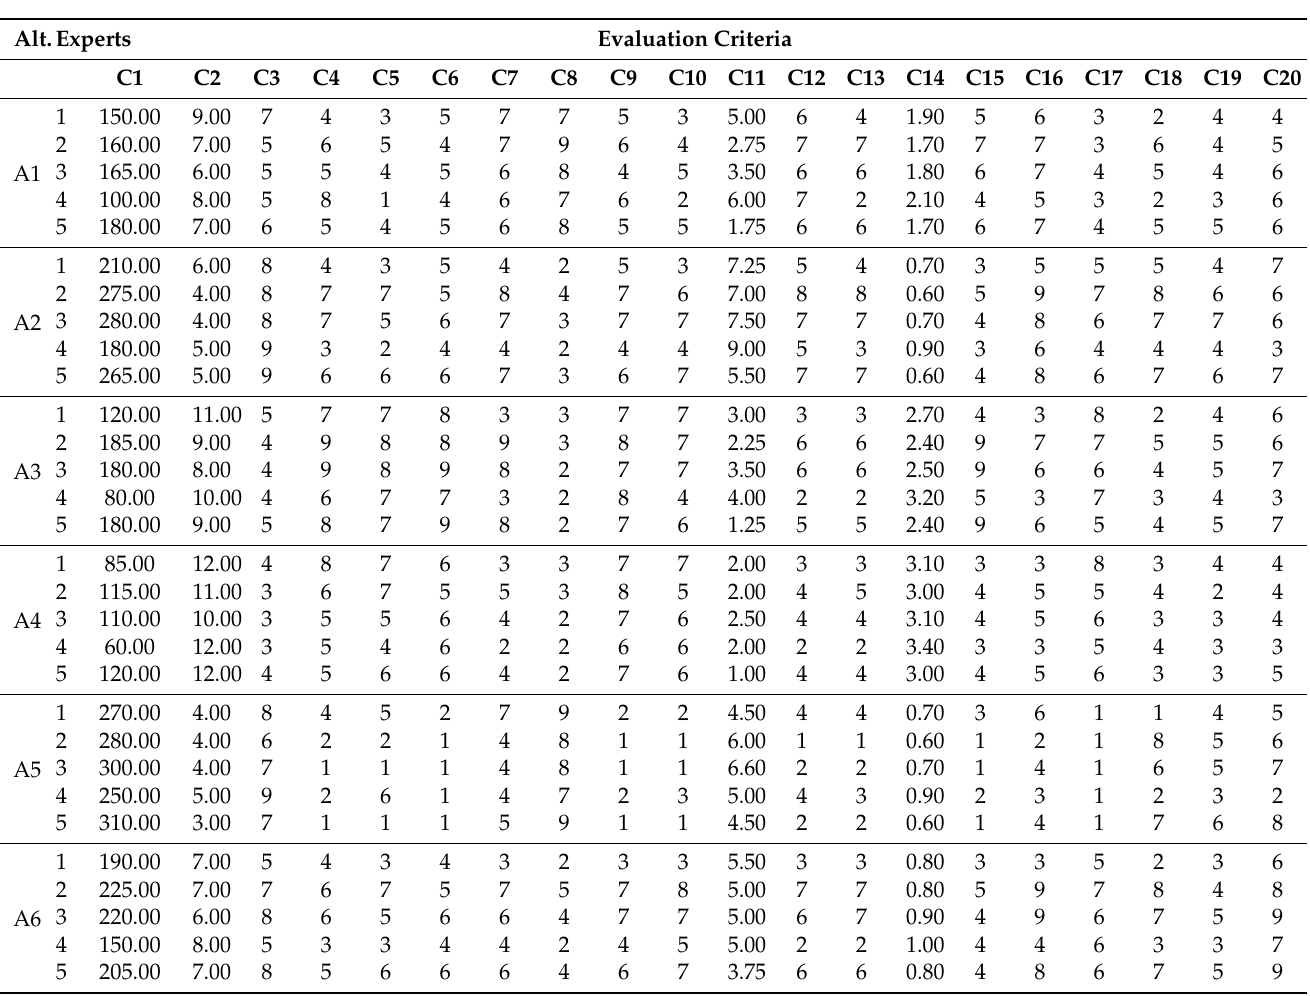
Table 5. Evaluation data for FWS